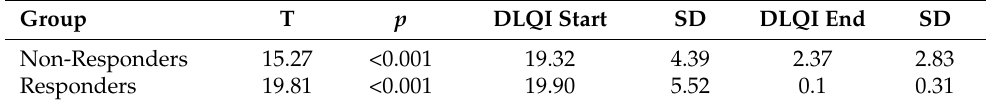
Table 6. Comparison of the changes in quality of life before and after the treatment in both groups.